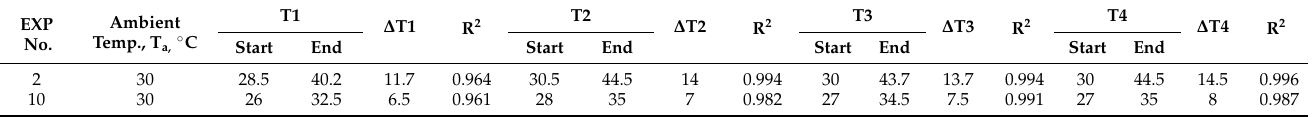
Table 2. Thermal coefficient for temperature profile data of Figure